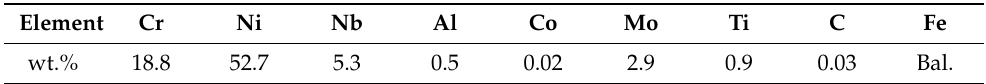
Table 1. Chemical composition of the Inconel 718 superalloy. Element